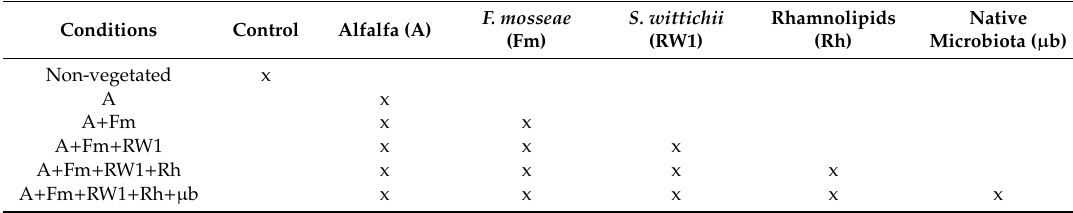
Table 2. Experimental design: Description of various conditions tested. x symbol means presence of the treatment in the